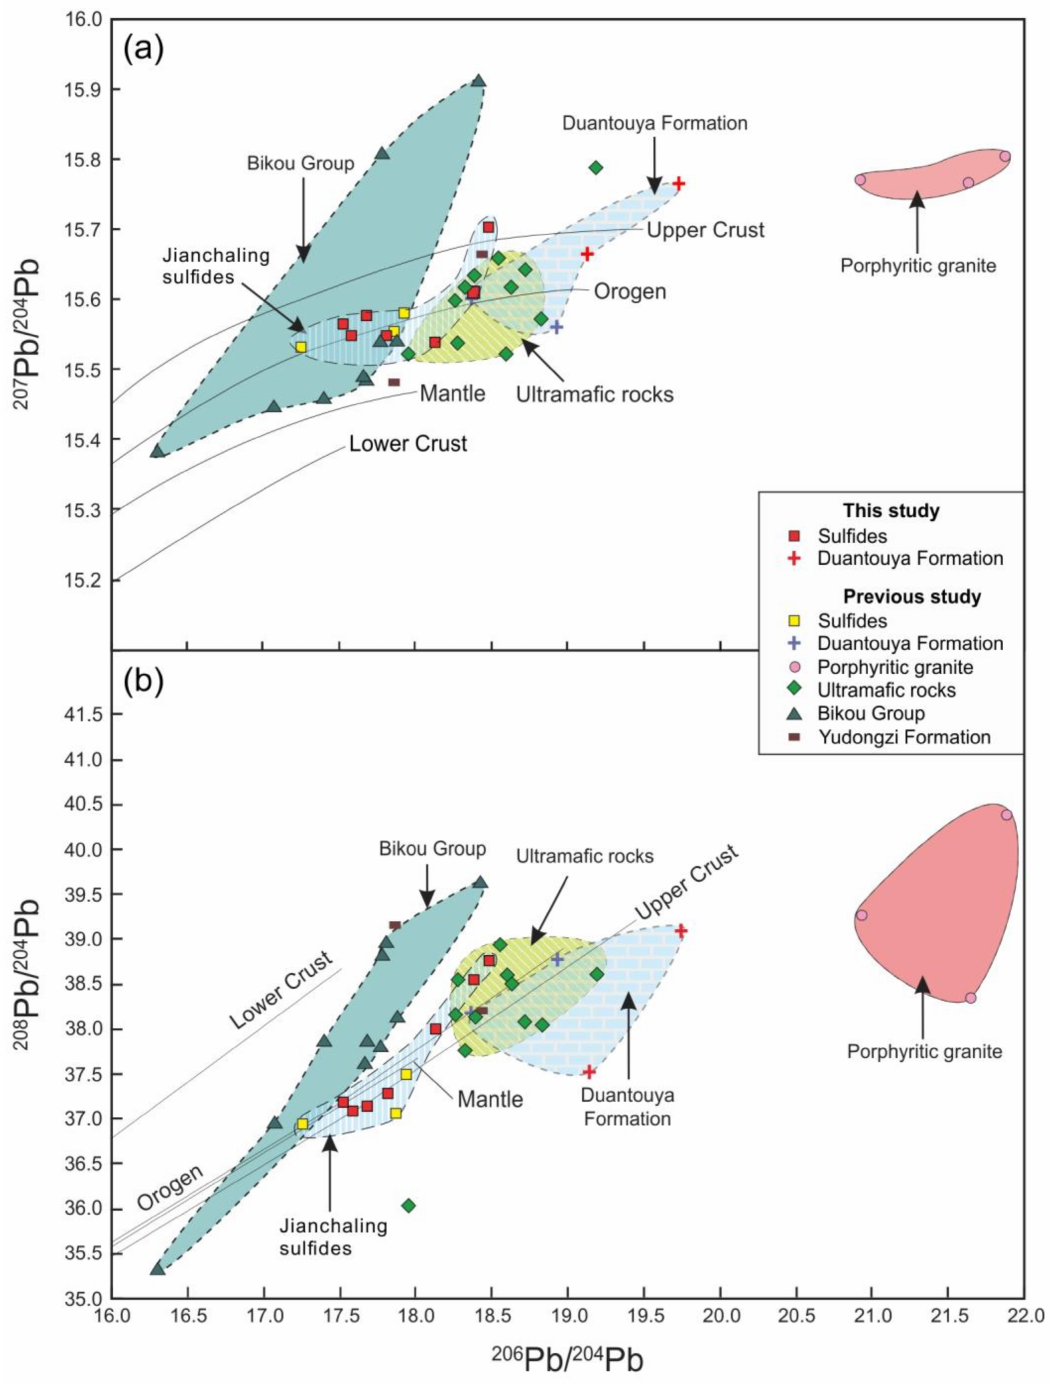
Figure 9. The plumbotectonic model for Pb isotopic systematics for the Jianchaling Au deposit. ( a ) 206 Pb/ 204 Pb versus 208 Pb/ 204 Pb; ( b ) 206 Pb/ 204 Pb versus 207 Pb/ 204